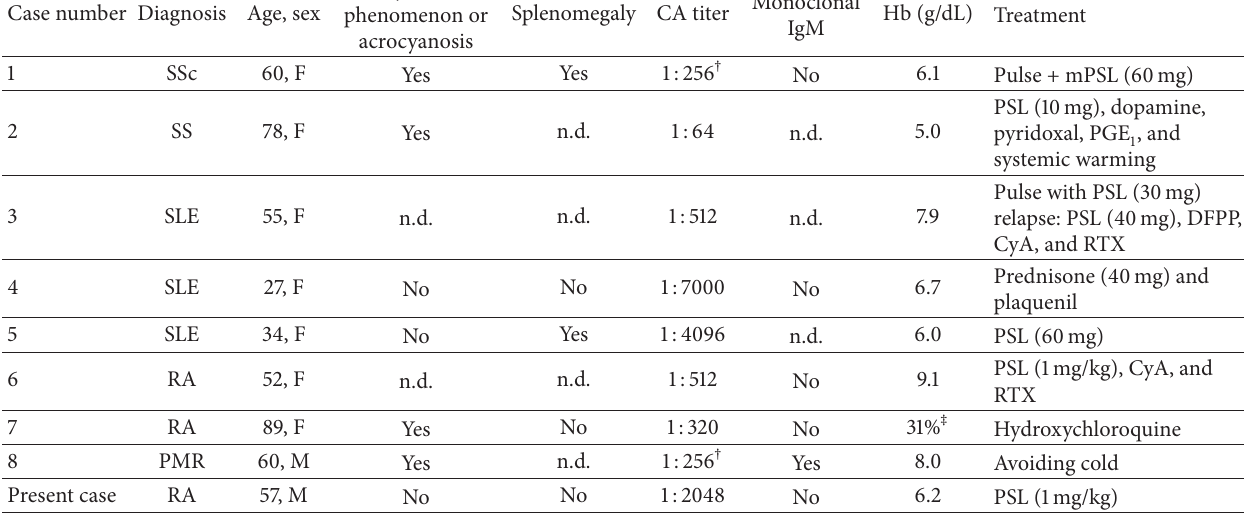
Table 1: Characteristics of the patients who had CAD associated with connective tissue diseases. Case number Diagnosis Age,